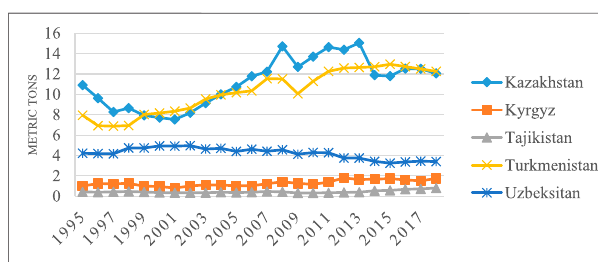
FIGURE 2 | Carbon emissions per capita in central asia.